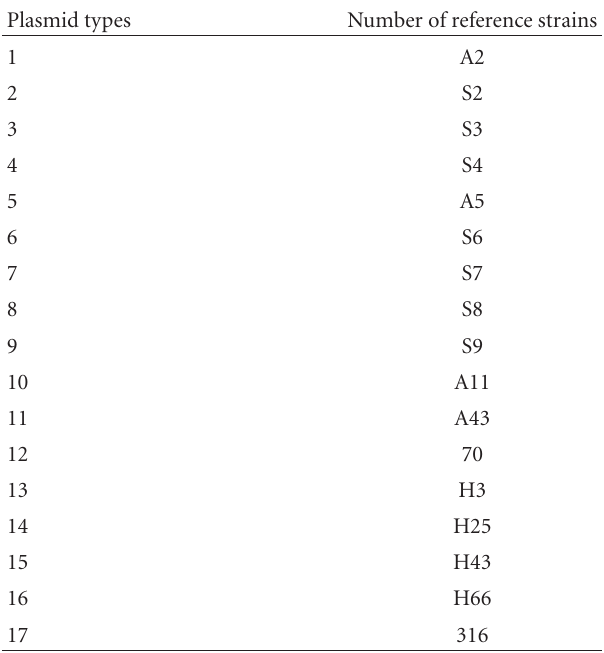
Table 1: The reference strains of intermediately virulent R. equi with human and pig origins were used in this